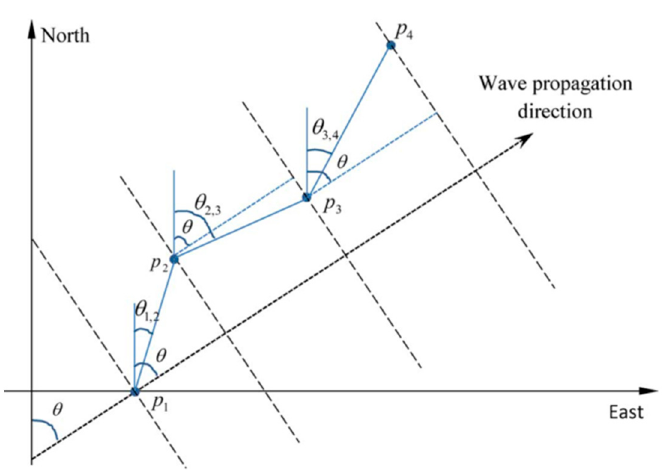
Figure 11. Geometry between Tsunami propagation direction and crossing points of reflection tracks on specific positions of Tsunami wave.